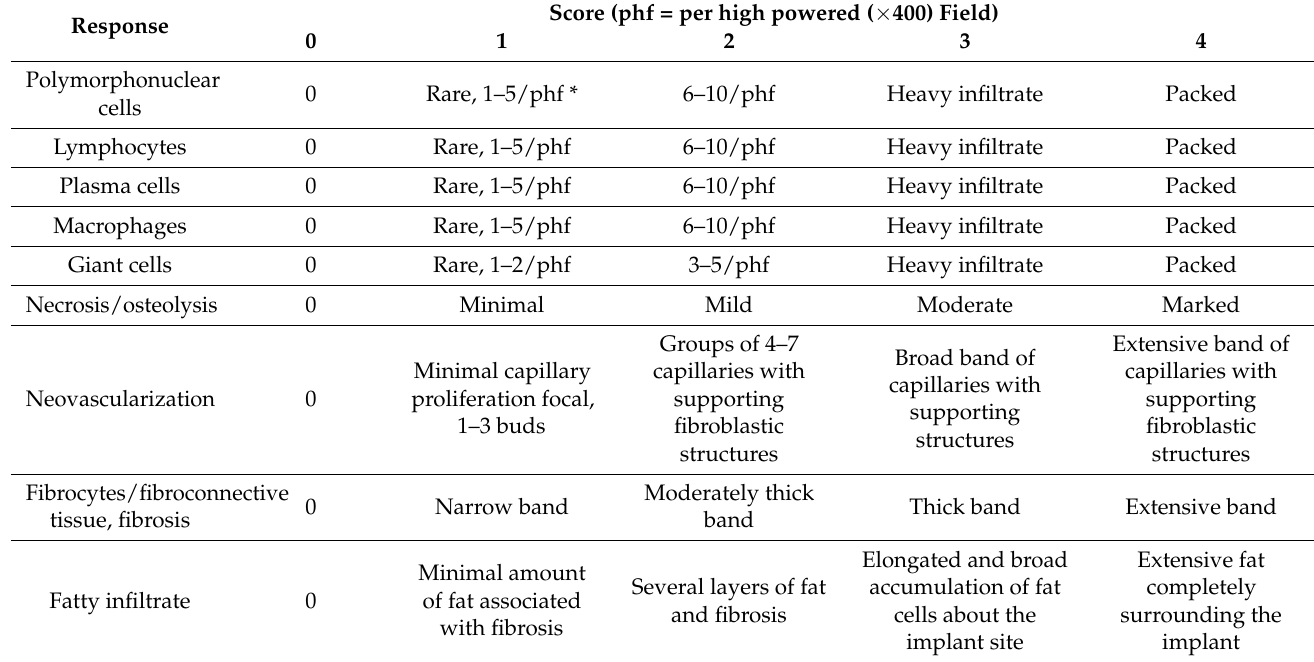
Table 10. Histologic Evaluation System for Irritancy/Reactivity—Cell Type/Response. Response